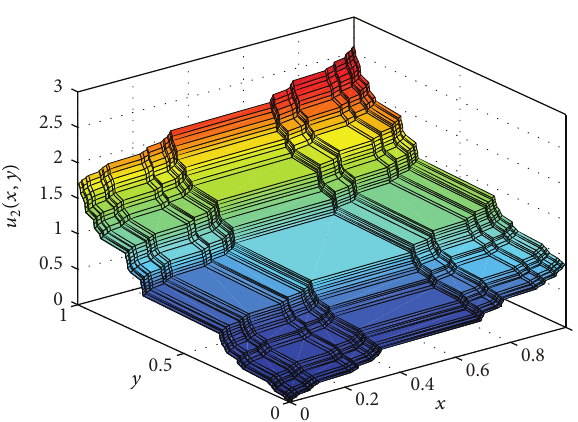
Figure 2: The plot of 𝑢 2 (𝑥,𝑦) with the parameter 𝛼 = ln 2/ ln 3 .